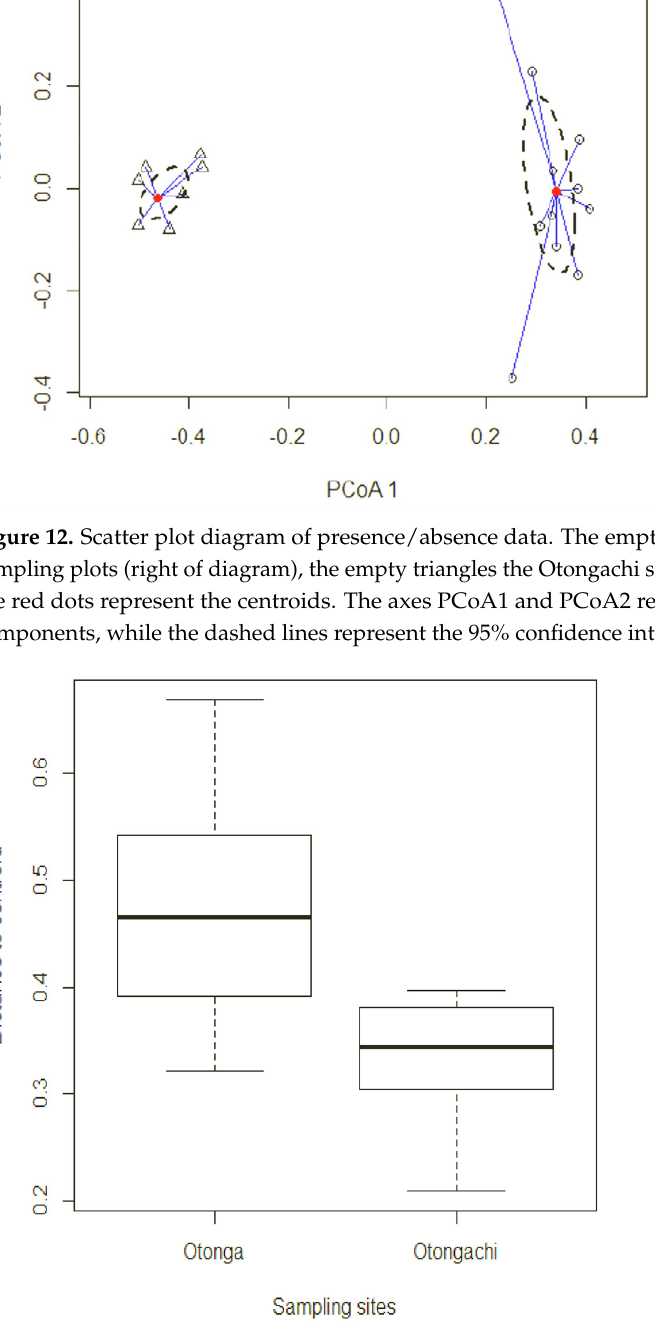
Figure 13. Distribution of the abundance of species in the plots of Otonga or Otongachi with respect to the distance from the centroid identified by PCoA analysis.